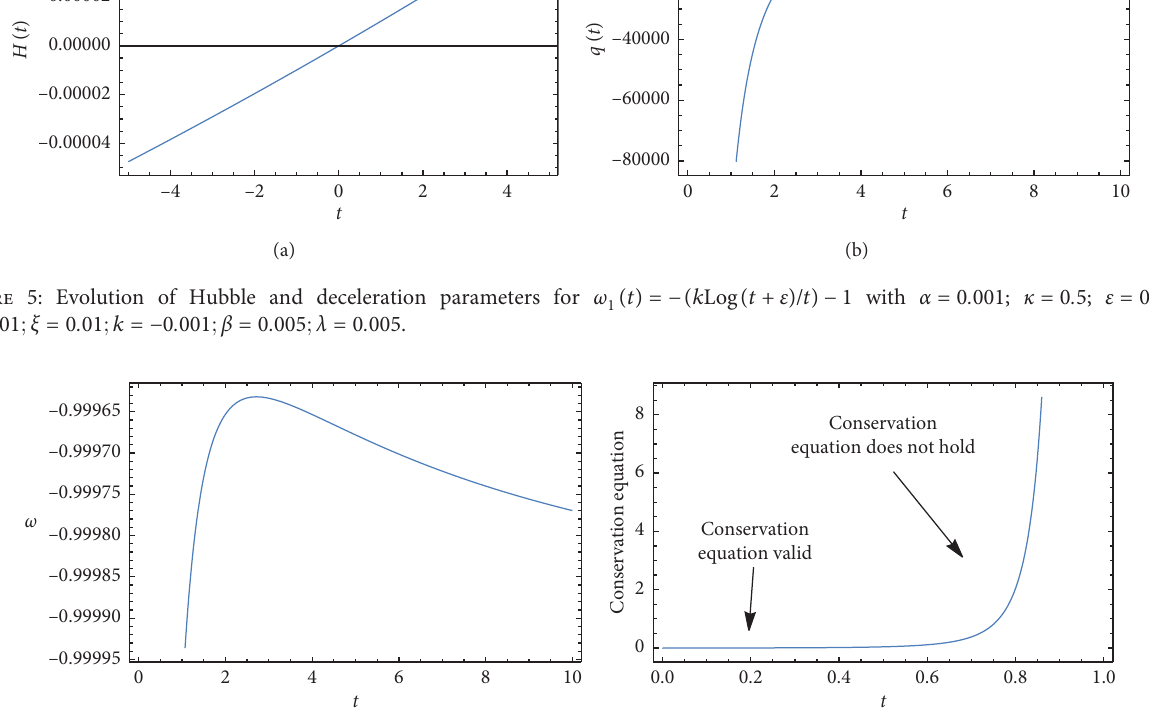
Figure 6: Evolution of EoS parameter ω ( t ) � − ( k Log ( t + ε ) / t ) − 1 and behavior of conservation equation with α � 0 . 001; κ � 0 . 5; 1 ε � 0 . 001; ζ � 0 . 01 ; ξ � 0 . 01 ; k � − 0 . 001 ; β � 0 . 005 ; λ � 0 .